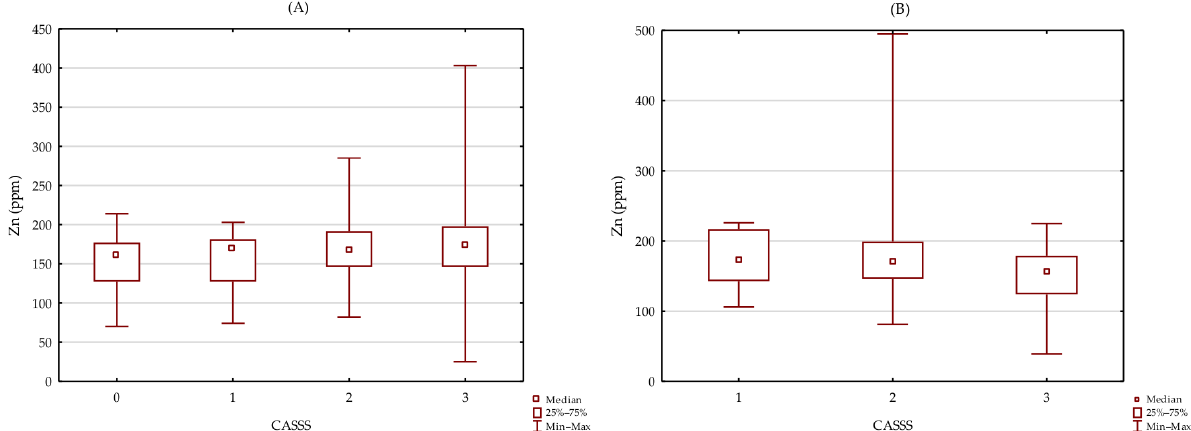
Figure 1. Association between Zn level and CASSS in group of patients without ( A ) and with history of MI ( B ).